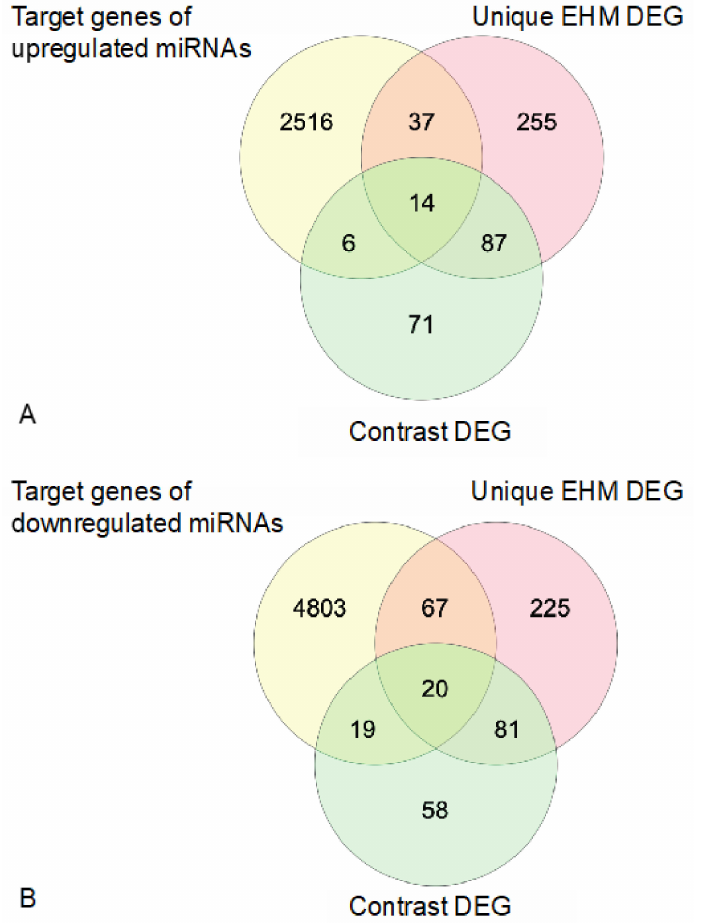
Figure 13. Venn diagrams highlighting genes identified as miRNA targets that were common to those differentially regulated in response to EHV-1 infection. ( A ) Predicted target genes of differ- entially upregulated miRNA that are common with differentially expressed genes unique to EHM horses (within group comparison) and/or differentially expressed genes in the contrast (between group comparison). ( B ) Predicted target genes of differentially downregulated miRNA that are common with differentially expressed genes unique to EHM horses (within group comparison) and/or differentially expressed genes in the contrast (between group)